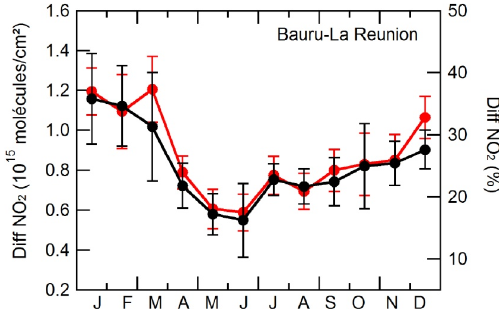
Figure 17. Seasonal cycle of the difference between Bauru and Re- union from SAOZ (black) and merged satellites